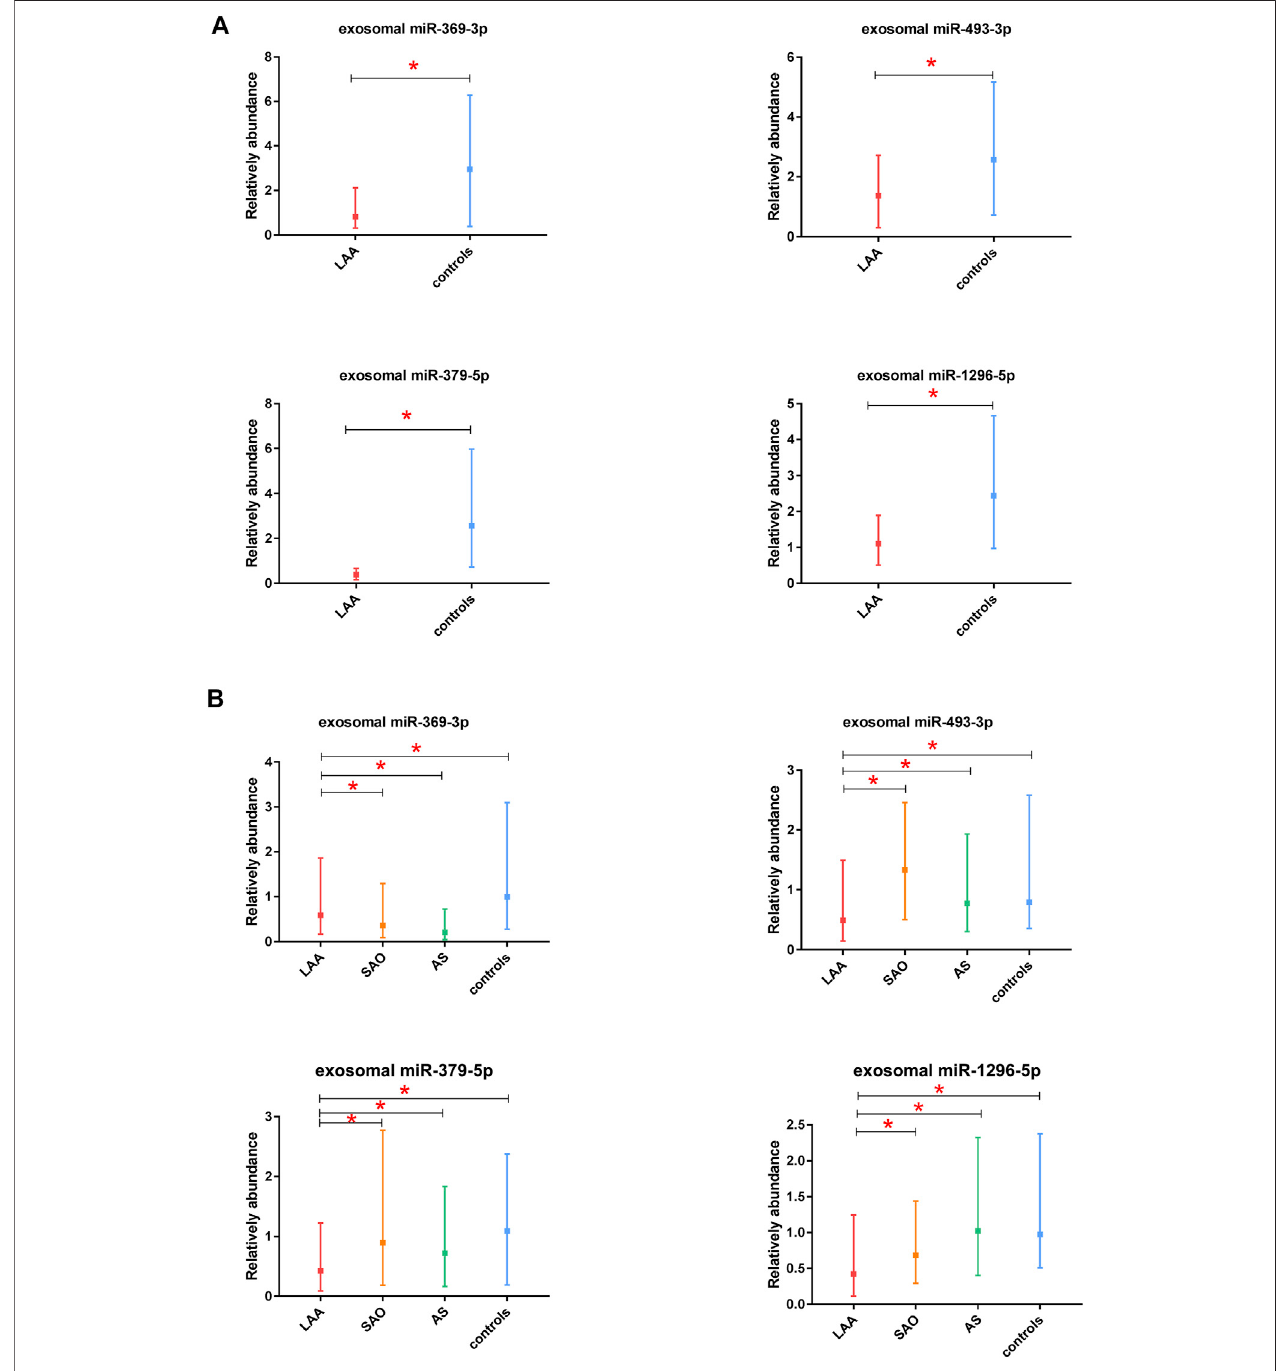
FIGURE 3 | Discovery and validation of exosomal miR-369-3p, miR-493-3p, miR-379-5p, miR-1296-5p. (A) . Results from the discovery phase. (B) . Results from the validation phase (median ± interquartile range, Mann-Whitney U test. * p < 0.05).